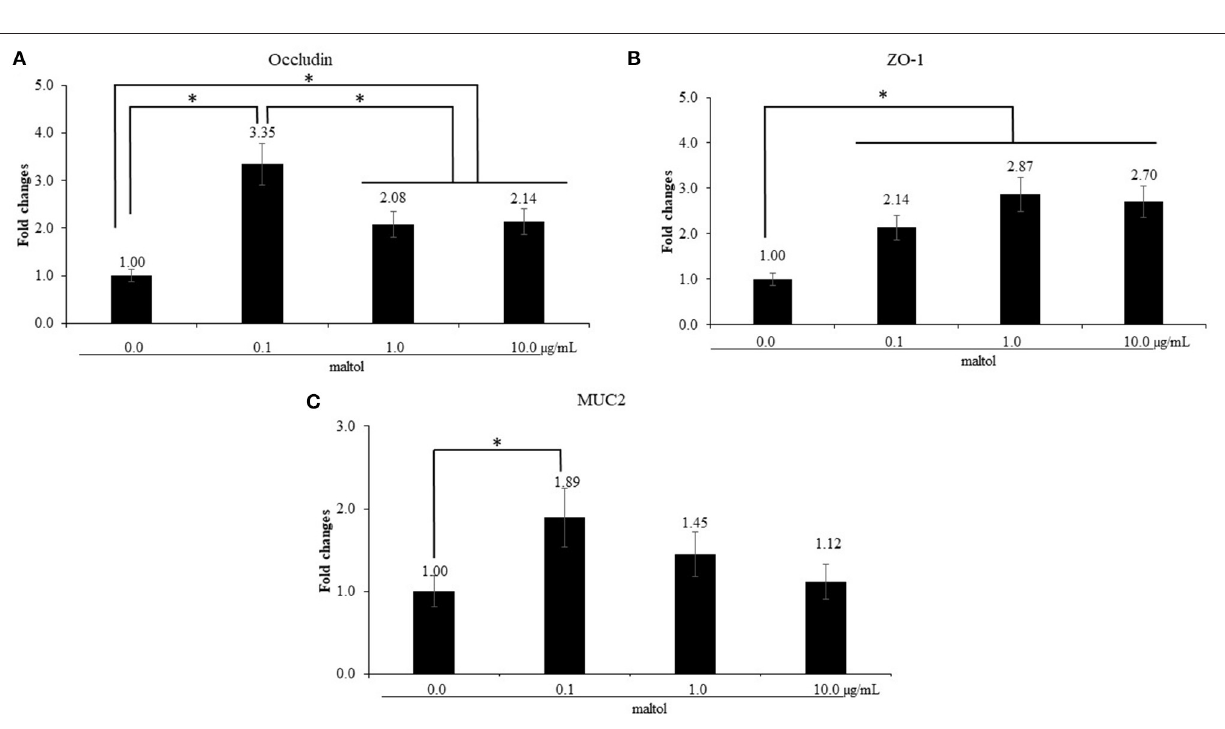
IL-1 β levels from 9.1- to 28.4-fold ( Figure 4A ). In